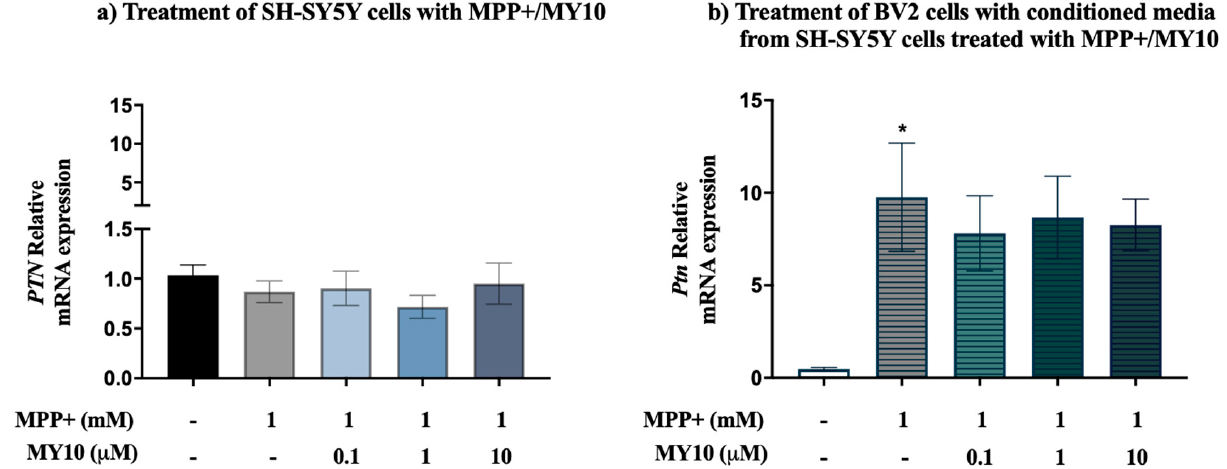
Figure 4. Upregulation of Ptn mRNA in microglial cells injured with conditioned media from SH-SY5Y cells treated with MPP+ and MY10. ( a ) Real-time PCR analyses of SH-SY5Y cells incubated with MPP+ and increasing concentrations of MY10 did not reveal significant differences in PTN mRNA expression. GAPDH and RPL30 were used as housekeeping genes in human SH-SY5Y cells. ( b ) Real-time PCR analyses of BV2 cells treated with the conditioned media from SH-SY5Y cells incubated with MPP+ and increasing concentrations of MY10 showed Ptn mRNA upregulation in BV2 cells. Rpl13 and Hprt were used as housekeeping genes in mouse BV2 cells. * p < 0.05 vs. Control.